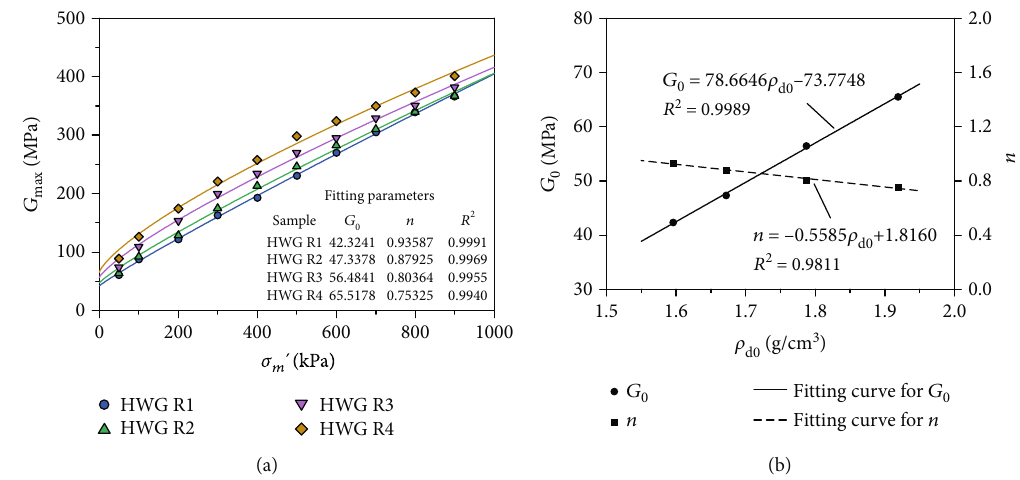
and n at initial dry densities of the 0